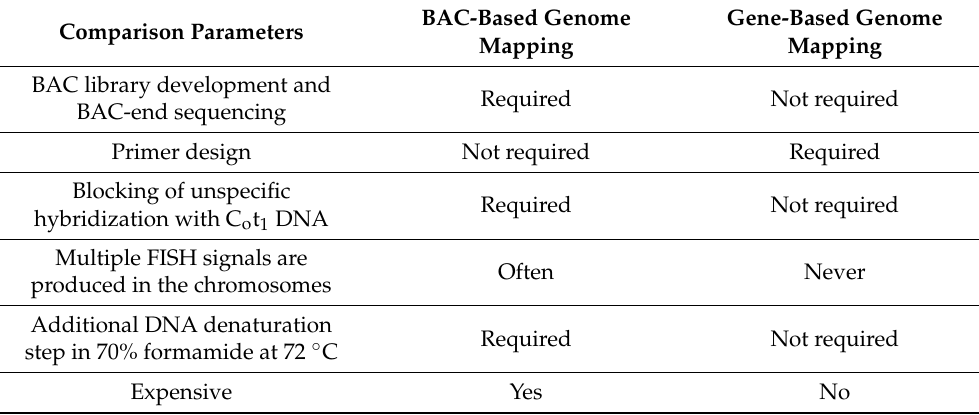
Table 2. Comparison of the Bacterial Artificial Chromosome (BAC)-based approach and the gene- based method for physical genome mapping. BAC-Based Genome Comparison Parameters